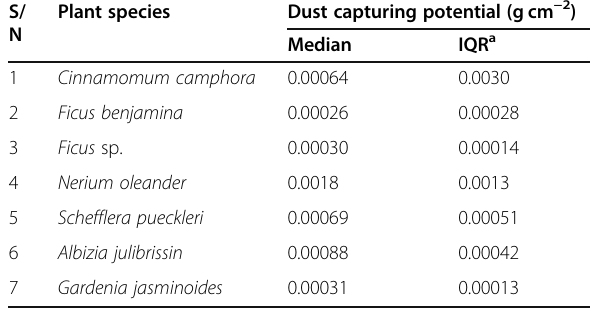
Table 2 Average ( n = 6) air pollution tolerance index of the studied plant species S/N Name of plant species APTI (Mean ± SD)